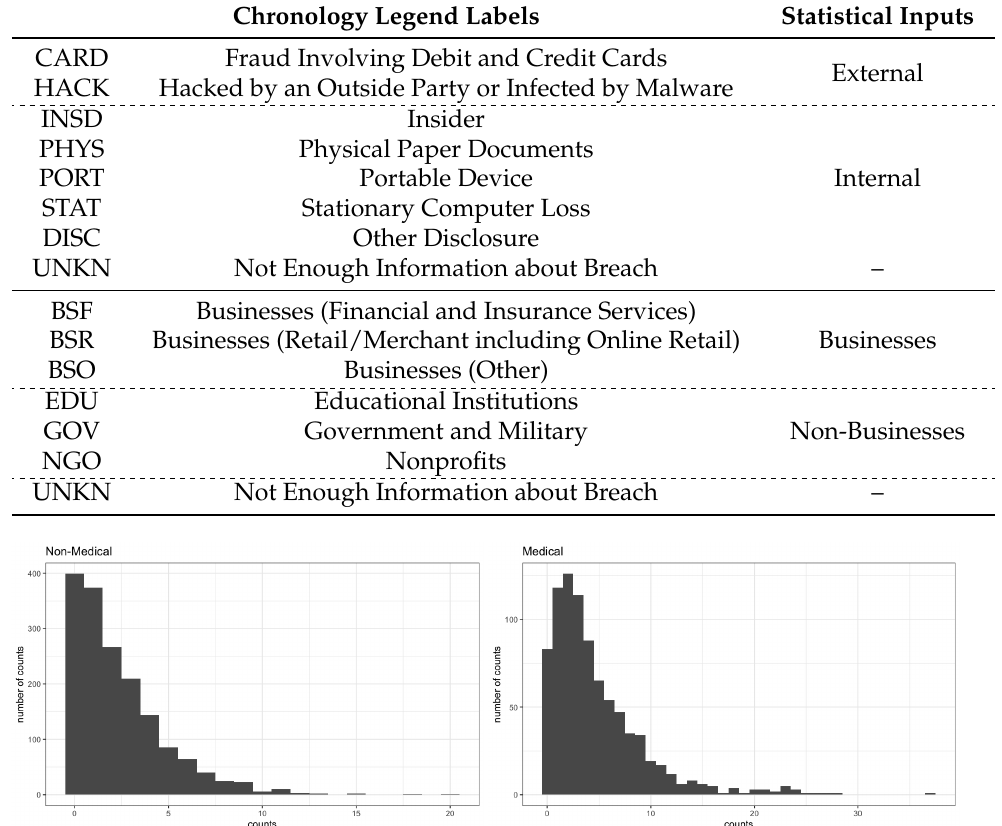
Table 1. Covariate level combination.